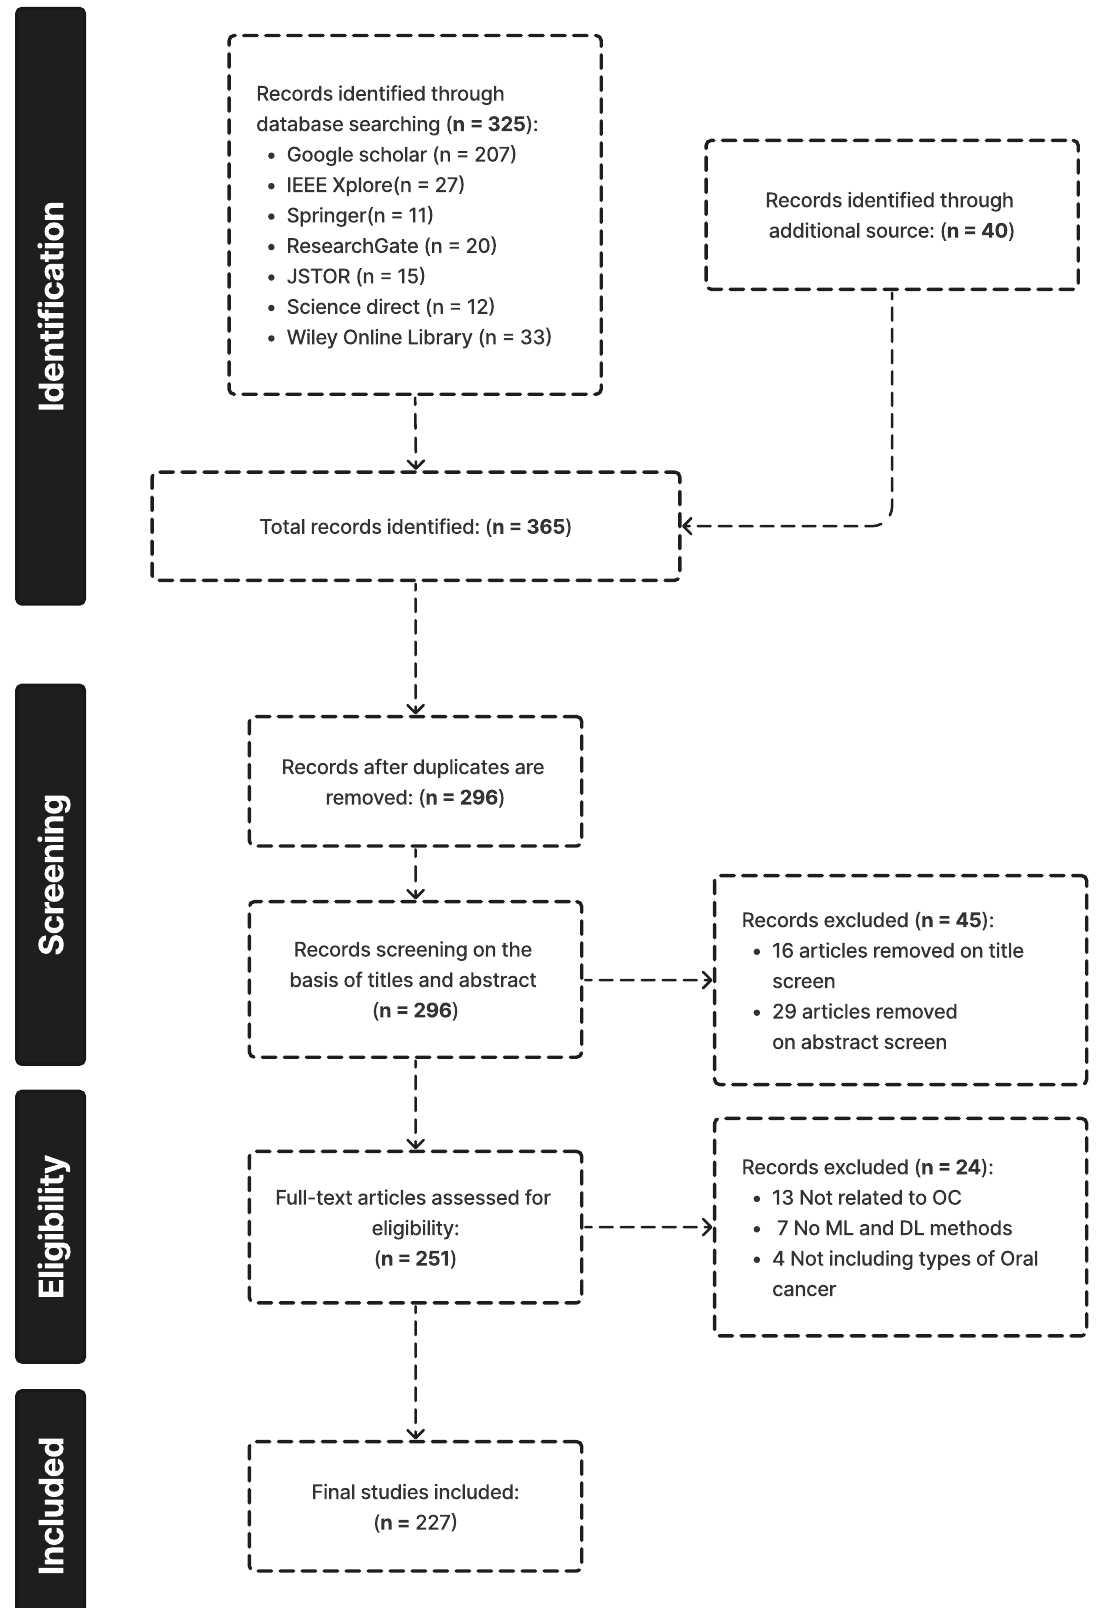
Figure 2. Articles were identified using the PRISMA method.